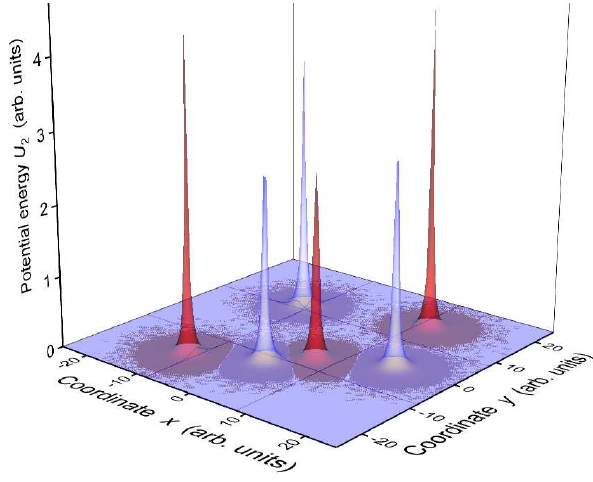
Fig. 2 . Random potential-energy field U dimensions x and y . The field shown is a sum of three Yukawa potentials of identical strength and range. The potentials only differ in their central positions. Two instantiations (‘ realisations ’) of the random field are shown in the figure.